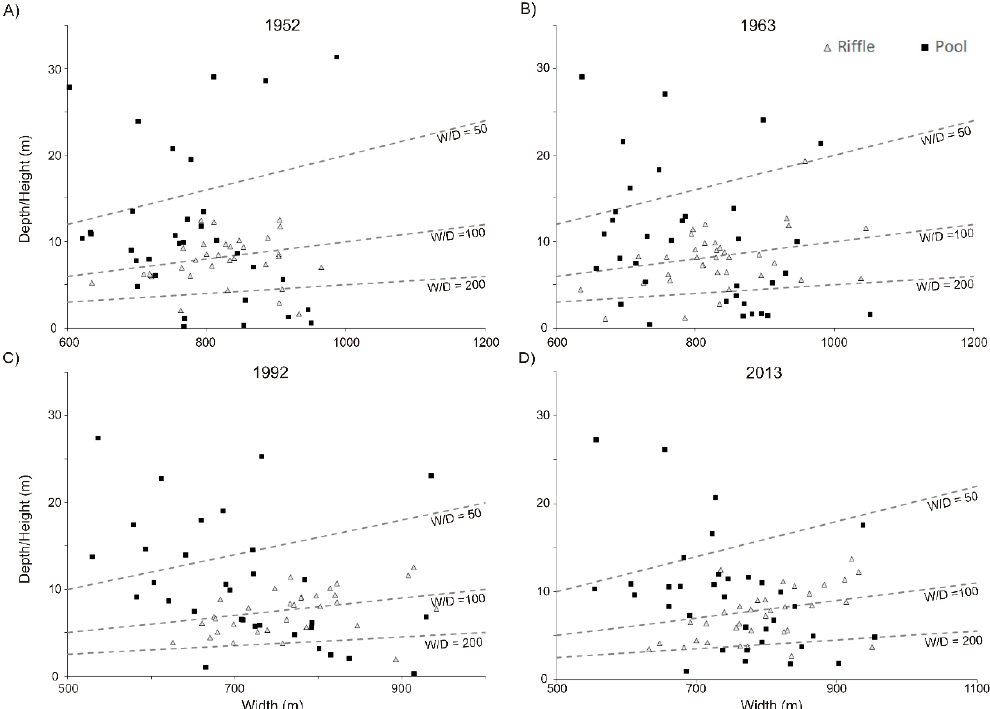
Figure 12. The depth vs. width for pools (solid squares) and the height vs. width for riffles (open triangles) in the upper reach at four different times: 1952 ( A ), 1963 ( B ), 1992 ( C ), and 2013 ( D ). Dashed lines represent constant width–depth ratios (W/D) of 50, 100, and 200. Note that the ranges of the x -axes in these four figures are slightly different.